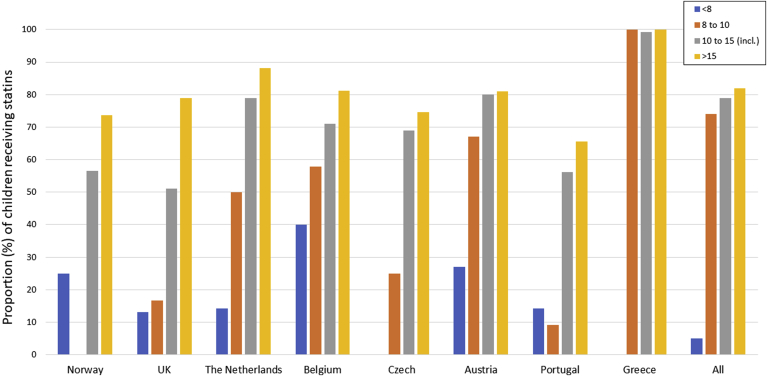
Proportions of children receiving statins by age at follow up per country.Children with follow-up data were grouped into age category (1. younger than 8 years, 2. from 8 to 10 years, 3. 10–15 years, and 4. over 15 years of age).